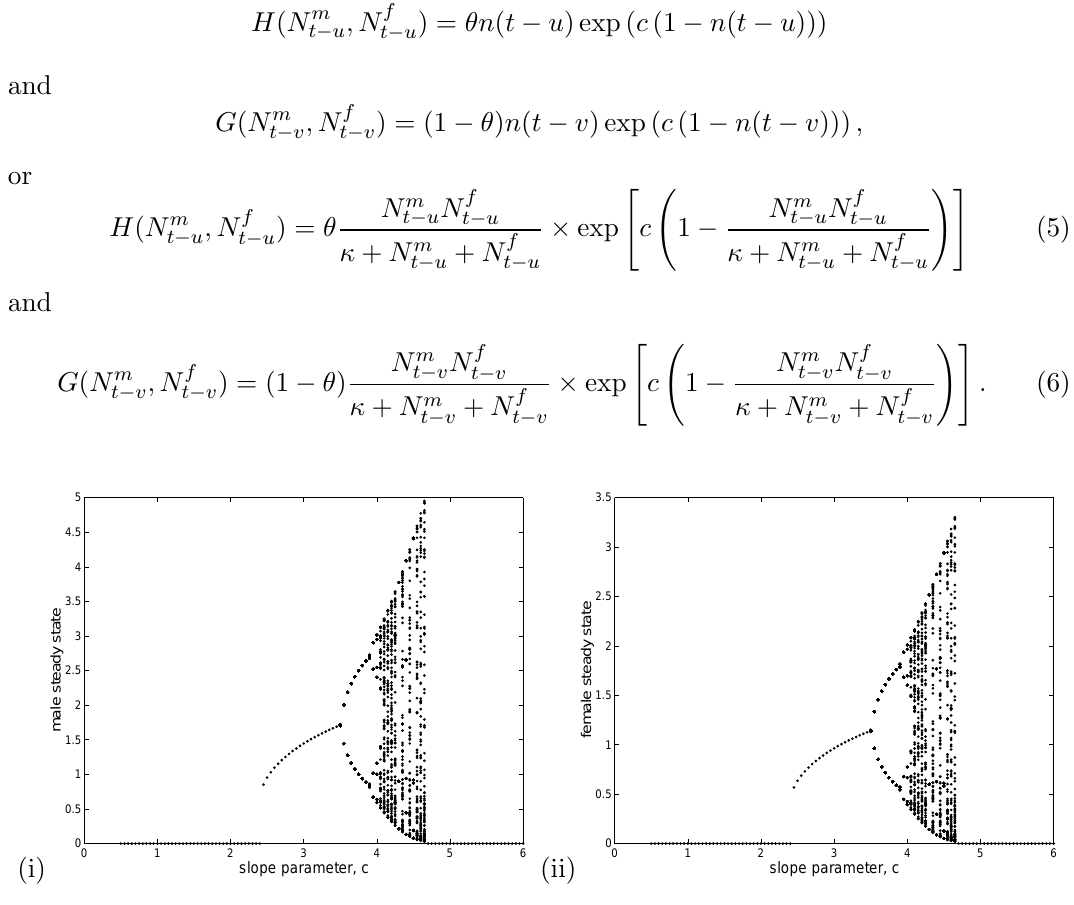
Figure 1: The dynamical solution at equilibrium of the two-sex model (3) using equations (5) and (6). (i) Male stock against the parameter c . (ii) Female stock against the parameter c , where θ = 0 . 6 , σ = 0 . 0 , and male and female delay factors are u = v = 0 . 0